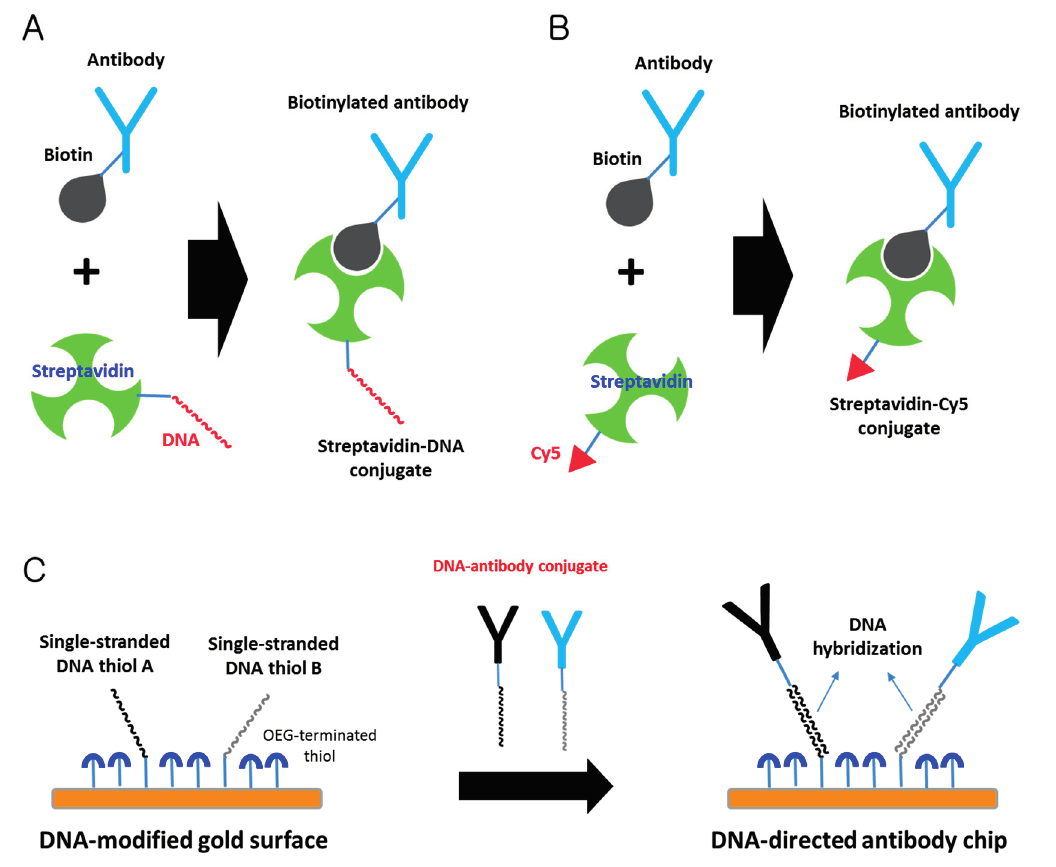
Figure 5. Schematic representation of DNA-directed immobilization. ( A ) Conjugation of four covalent conjugates (HA-HD) with the biotinylated antibodies anti-carcinoembryonic antigen (RAC), anti-ceruloplasmin (SAC), anti-complement-1-inactivator (SCI), and anti-lectin (GAL) to generate capture reagents A-RAC, B-SAC, C-SCI, and D-GAL. Adapted from [97]; ( B ) Conjugation of Streptavidin-Cy5 with biotinylated RAC, SAC, SCI and GAL for the use of a microscaled fluorescence immunoassay. Adapted from [97]; ( C ) DNA-directed immobilization of DNA-linked antibodies. c-A (Target sequence conjugated to anti-hCG): 5'-AGC GGA TAA CAA TTT CAC ACA GGA-3'; c-B (Target sequence conjugated to anti-hLH): 5'-AAC AGC TAT GAC CAT GAT TAC-3'; OEG, oligo (ethylene glycol). Adapted from